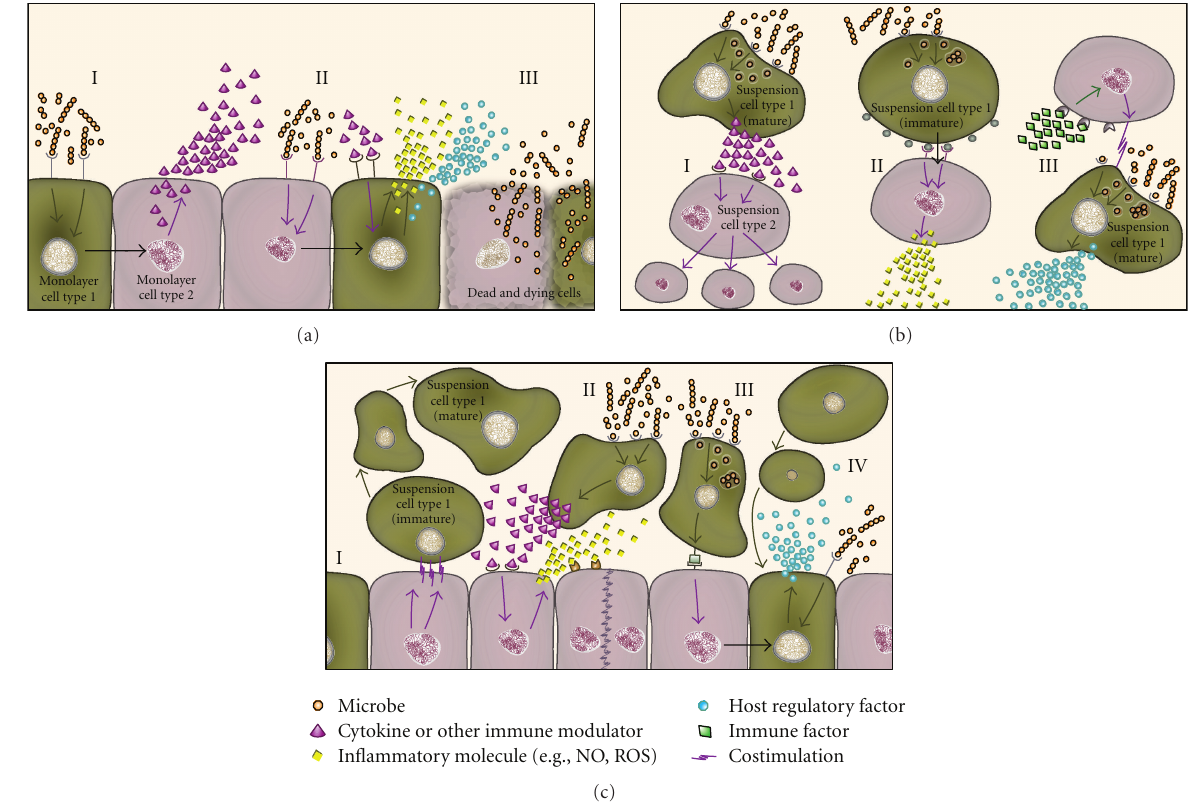
Figure 1: Examples of coculture models for the study of infection. A. Monolayer cocultures typically incorporate epithelial cells and another adherent cell type(s) and these detect microbes (I) and signal via juxtacrine mechanisms (black arrow) to cells in the monolayer to induce synthesis of immune factors and cytokines. Microbes that bind or invade epithelial cells may induce signals from the partner cell types in the monolayer, which can release inflammatory molecules (II) such as nitric oxide (NO) or reactive oxygen species (ROS). In models that utilize viable microbes overgrowth can lead to cytotoxicity of host cells in the monolayer (III) and may limit the study. B. Suspension cocultures often utilize phagocytes that ingest microbes and signal other cells to proliferate (I). Suspension coculture models sometimes use dynamic conditions such as rolling and may incorporate immature or mature versions of cell lineages such as monocytes or macrophages. Intercellular signalling can occur via juxtacrine pathways (black arrow) where receptors are ligated and can lead to the induction of inflammatory molecules (II). Alternatively, cells may respond to immune factors as co-stimulatory molecules that are required for optimal responses to microbes (III) such as production of regulatory factors. C. Mixed cocultures typically utilize adherent monolayers in combination with a suspension cell type(s), which can respond to co-stimulation by di ff erentiation (I). Microbe binding to suspension cells may lead to cytokine/immune factor signalling of the adherent cells to induce the secretion of inflammatory molecules by the monolayer (II). Phagocytes present in the coculture may ingest microbes and signal to the adherent cells via an unknown receptor mechanism to promote juxtacrine signalling between cells (black arrow) as a means to trigger downstream regulatory factors (III). Microbe binding to adherent cells may stimulate paracrine signalling to suspension cells, recruiting them towards the monolayer